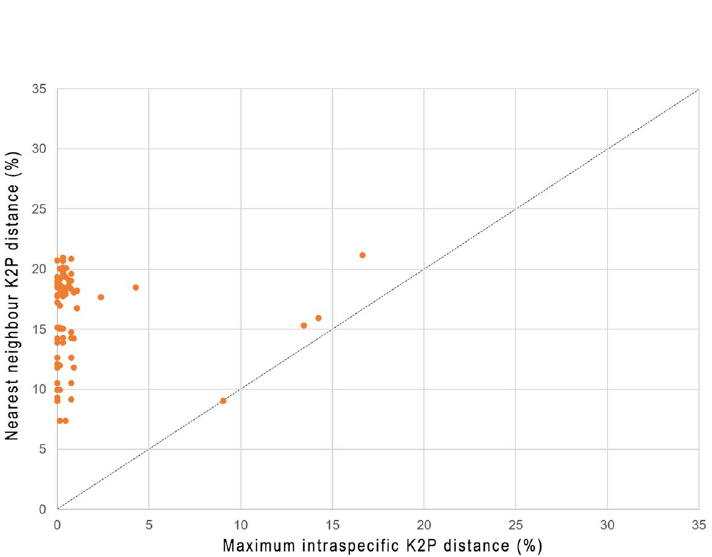
Figure 3. Scatterplot of maximum intraspecific K2P distances vs. the nearest neighbour K2P